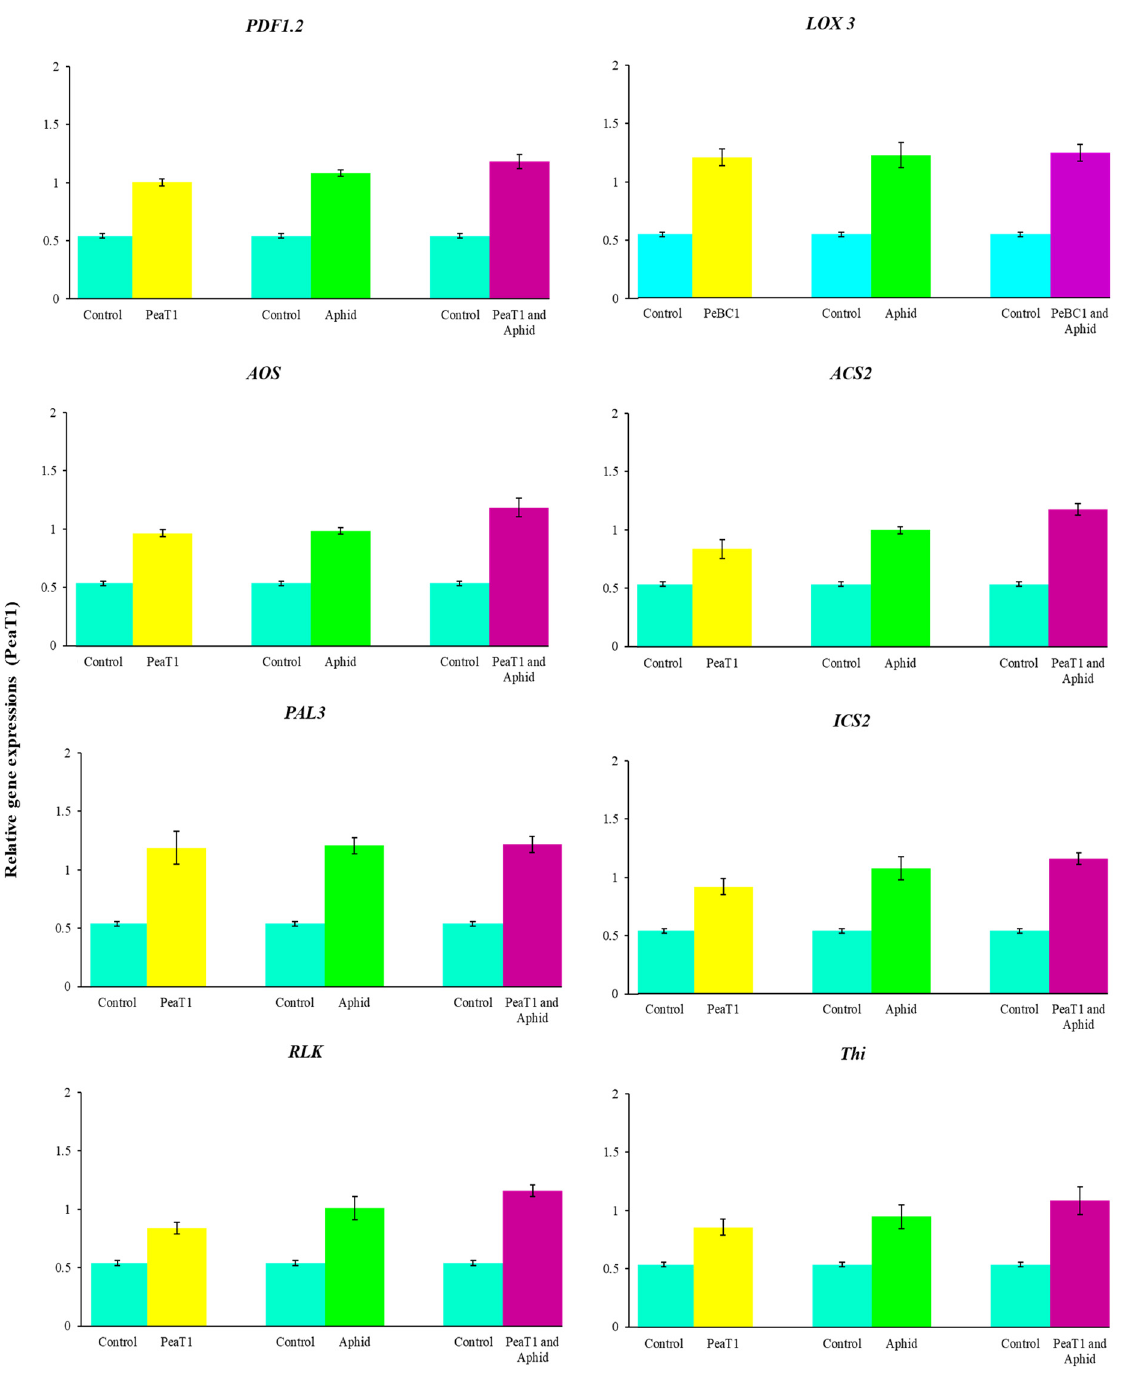
Figure 9. Treatment with PeaT1-elicitor, PeaT1 with aphid, and aphid infestation alone revealed relative expression of the JA, SA, and ET pathway genes. One day after spraying, PeaT1 treatment was carried out. The aphids were inoculated one day after the seedlings were sprayed in both treatments, and the samples were collected one day later. Using SPSS 18.0, data were compared using LSD, one-way ANOVA, and Levene’s test. The fold expression of treated chilli seedlings is represented by bars. Controls were given a relative fold expression of 0.54.